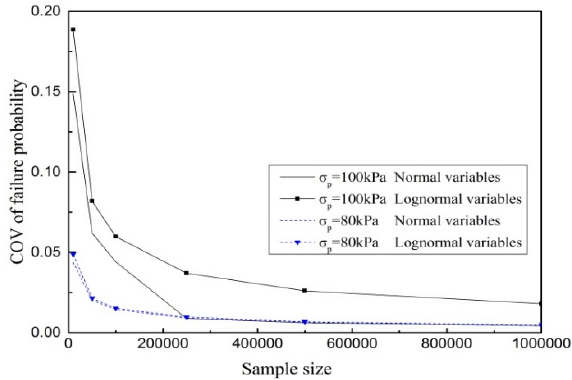
Figure 4. Influence of sample size on COV of the failure probability.